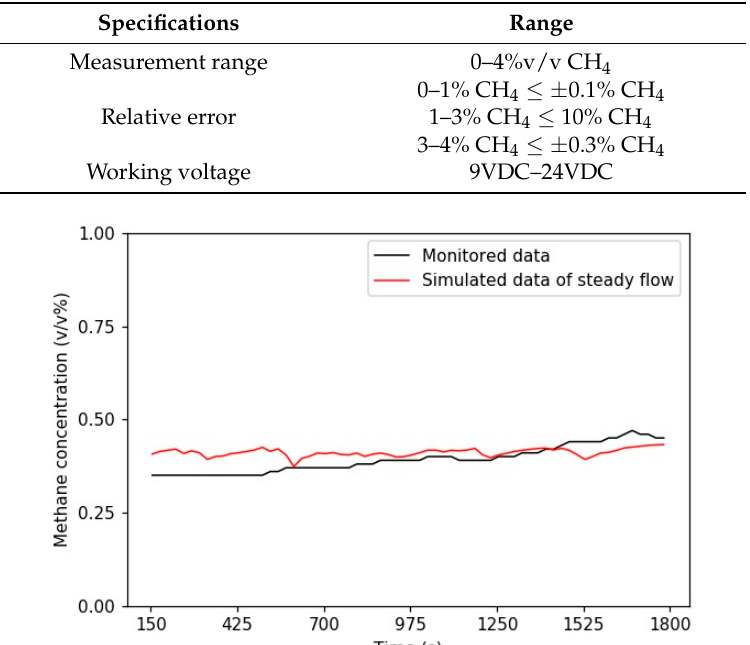
Table 5. Specifications of the methane sensor (type KJ9701A).